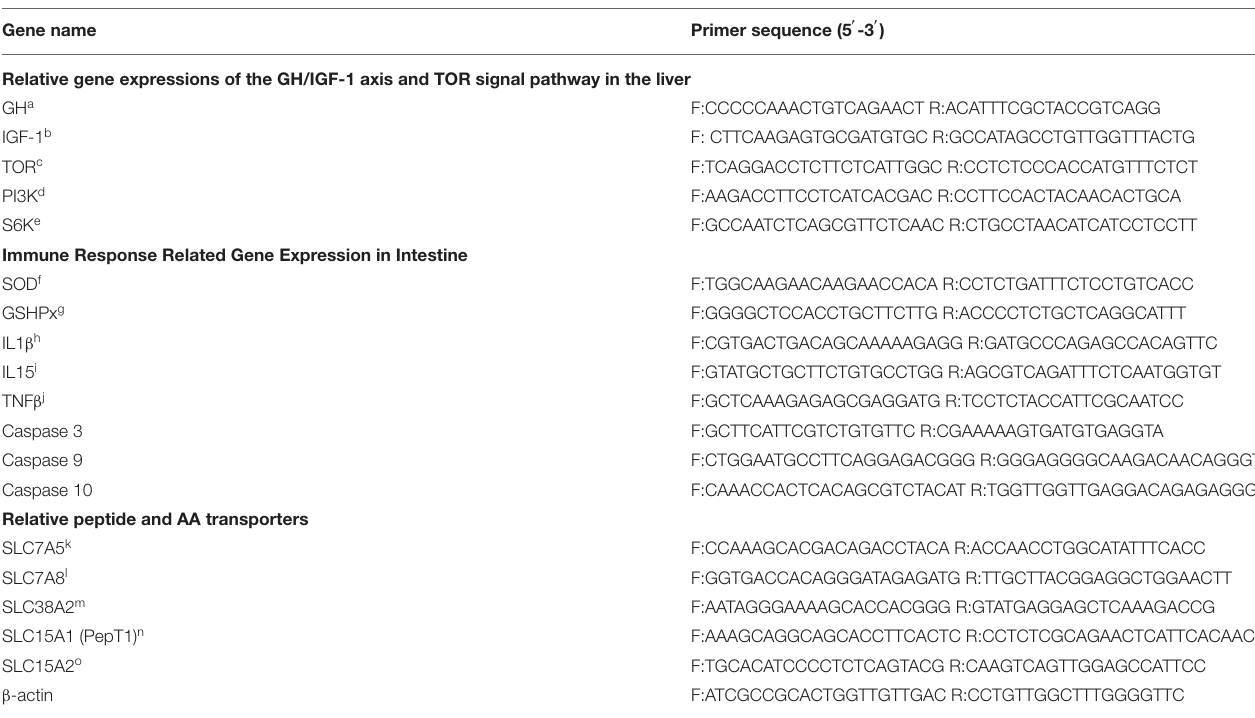
TABLE 4 | Primers used for the quantitative RT-PCR